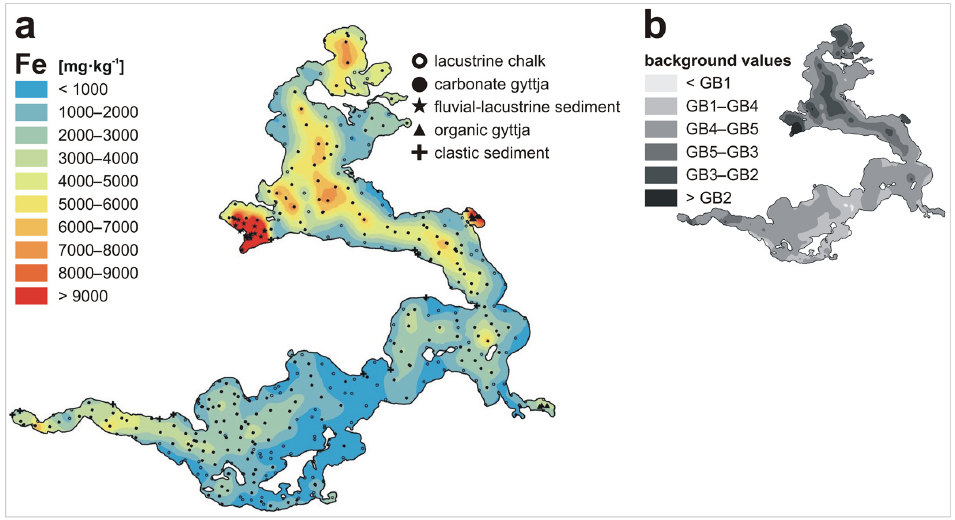
Figure 3. Iron in recent bottom sediments of the Wigry Lake: ( a ) spatial distribution of Fe; ( b ) Fe mapped according to different geochemical background values implemented in the study (Table 3).